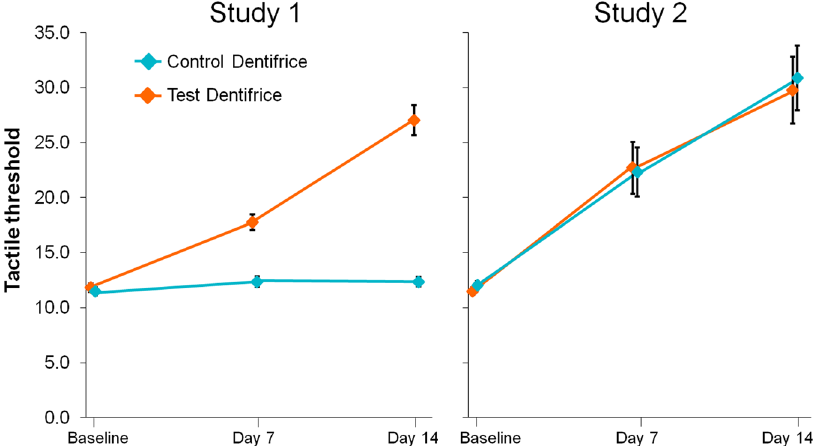
Fig. 3 Effect of treatments on Tactile threshold scores. Values are adjusted means (±SE). Data are offset for clarity. Tactile threshold score range: 0 – 80 g. High values are